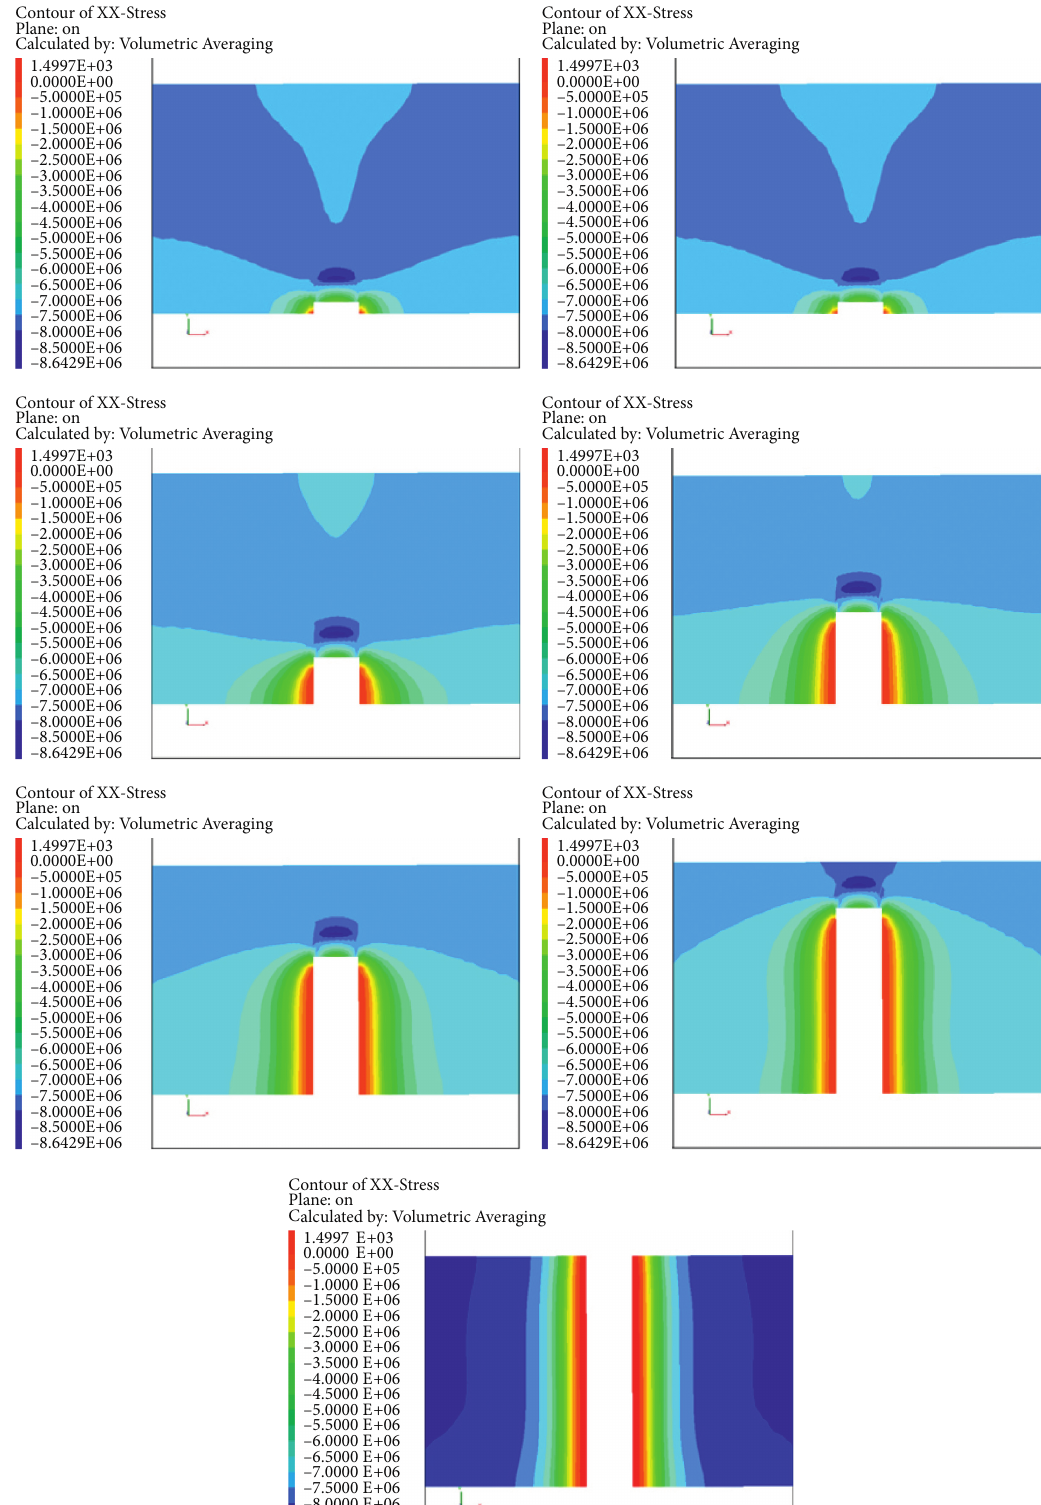
Figure 6: Stress development of rock mass in two sides of the